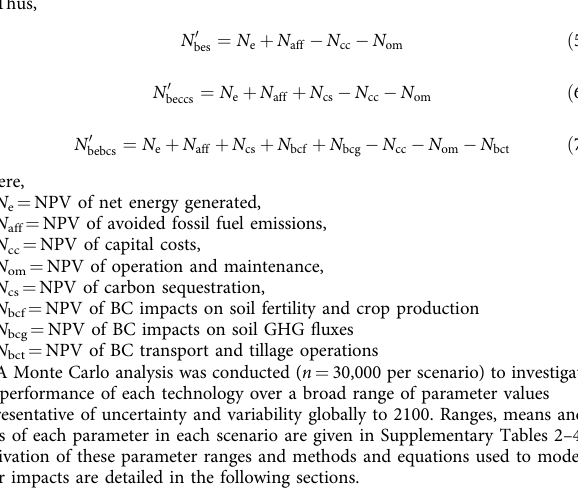
Table 8. In 2010, the global carbon intensity of electricity generation was 0.04Mg C GJ e (cid:2) 1 (where GJ e is a GJ of electrical energy generated (page 741, fig.7.7 in ref. 38). Avoided carbon emissions from the reference energy system (AE ref ) were then calculated as electricity produced by BES ( E bes ) multiplied by carbon intensity of the reference energy system (CI ref ) (equation